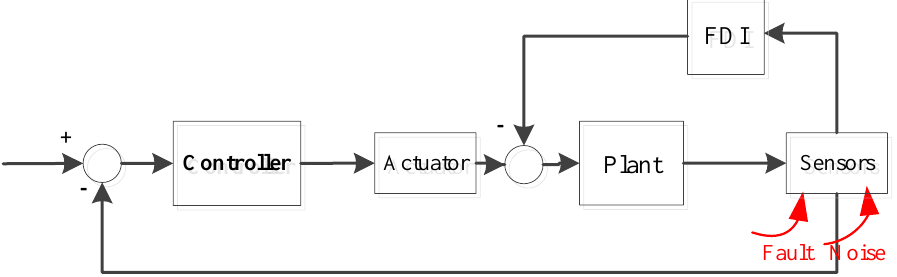
Figure 6. The general structure of the analytical feedback compensation active FTC